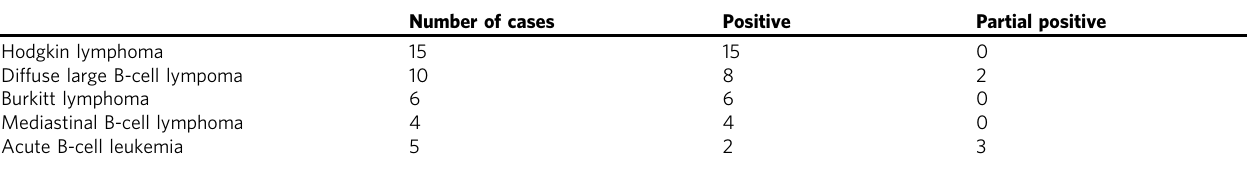
Table 1 Immunohistochemical analysis of GOT2 distribution in B-cell lymphoma Number of